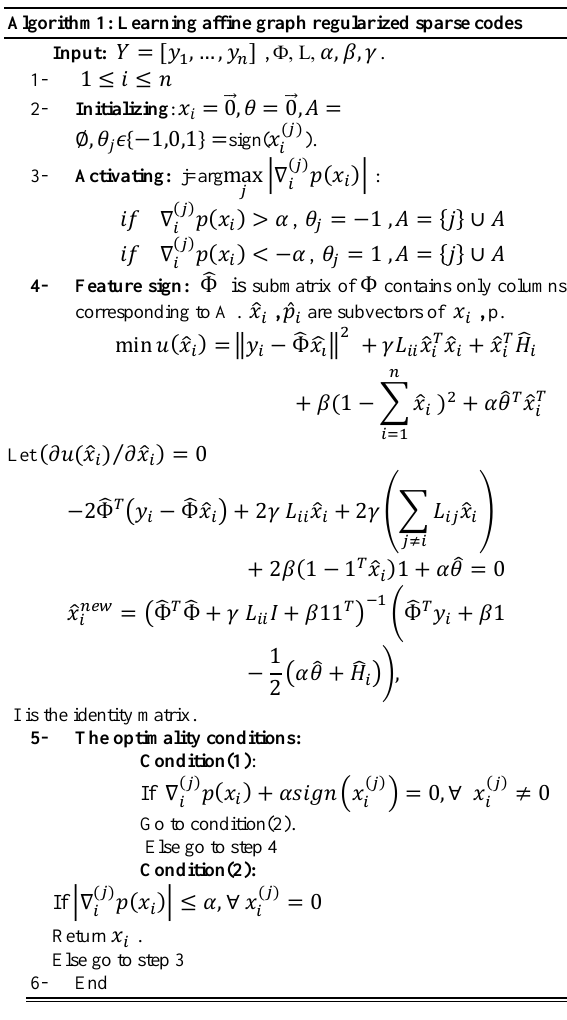
algorithmic procedure of learning affine graph